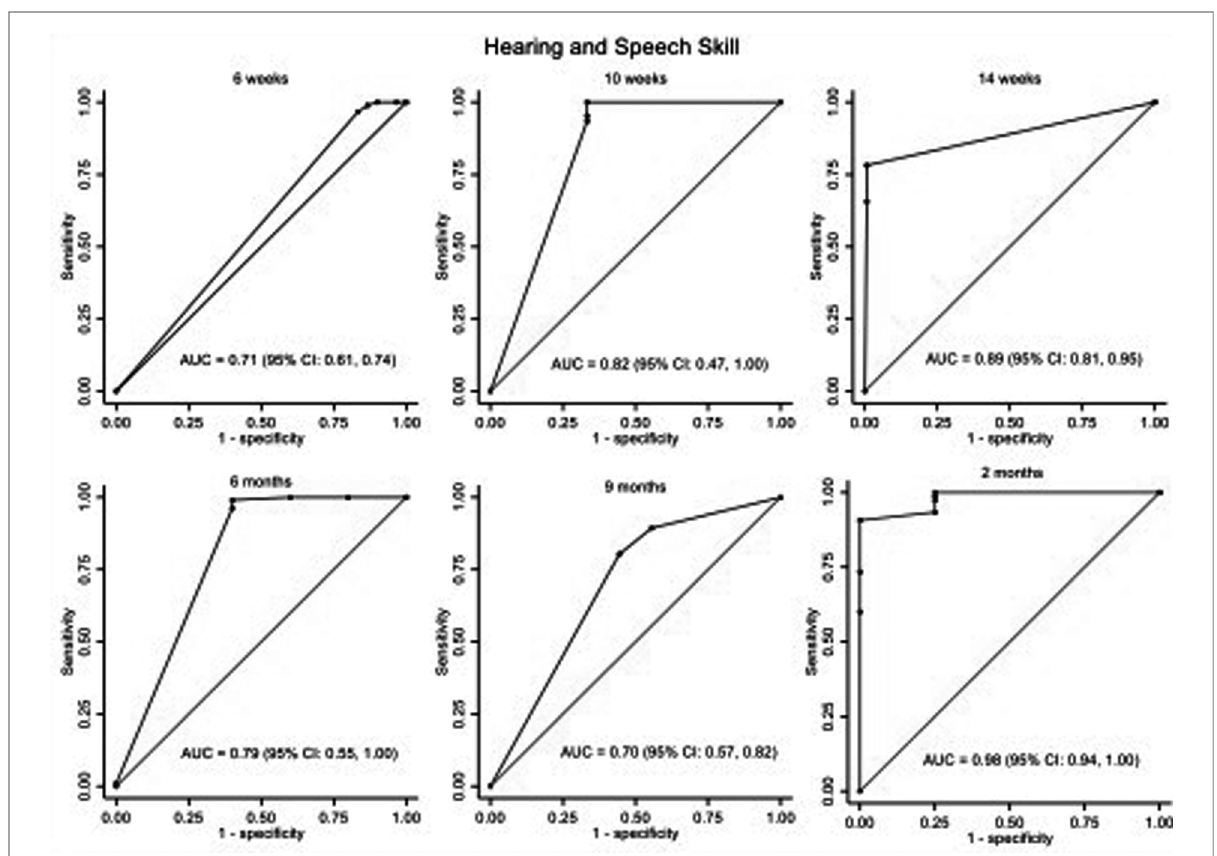
FIGURE 2 ROC curves showing the performance of ISDS in the detection of delay in hearing and speech domain at the age-speci fi c optimal